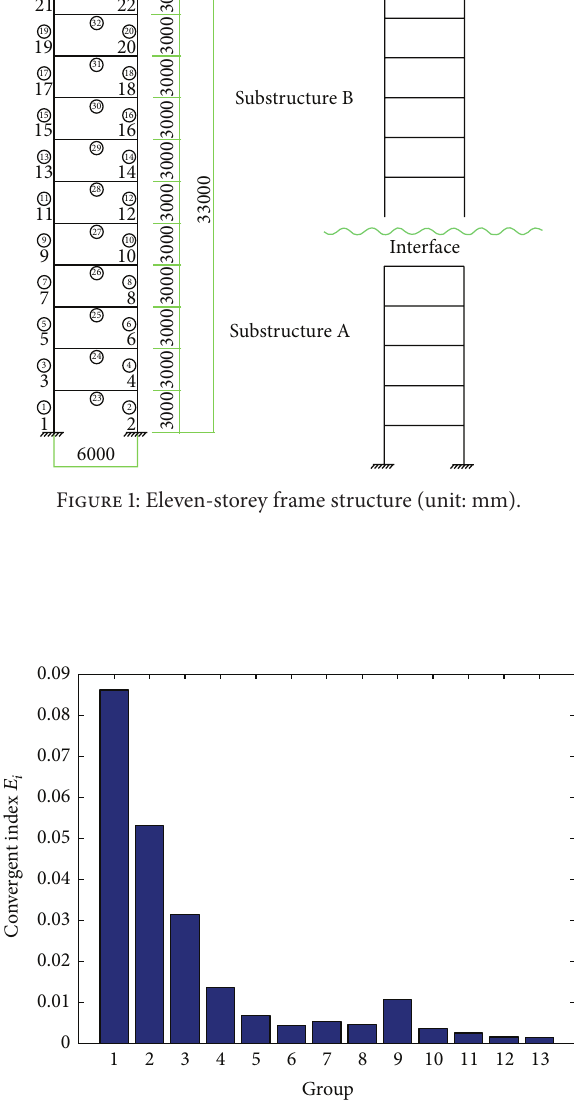
Figure 2: Convergent index E 𝑖 with increasing retained